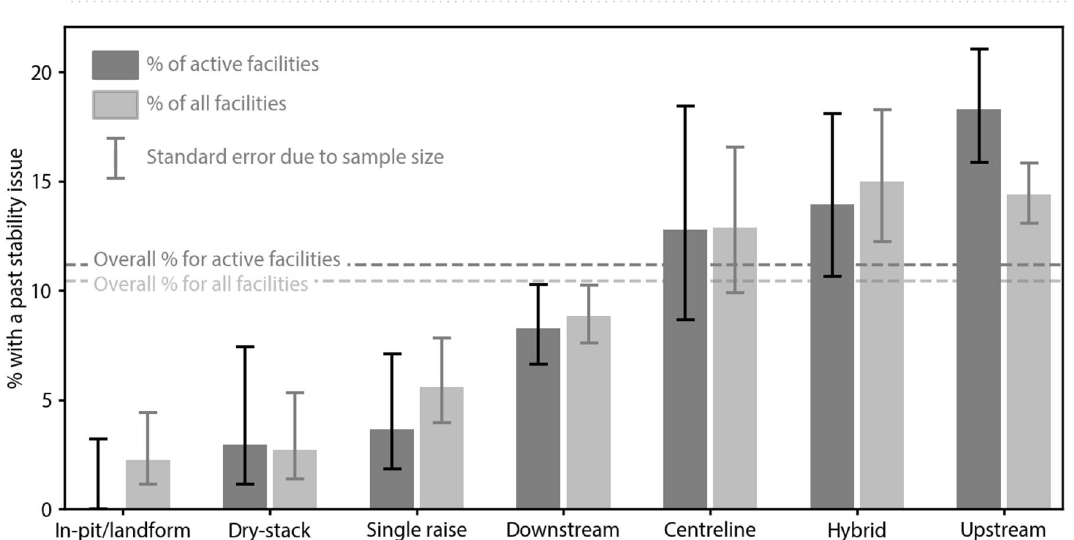
Figure 3. Stability of tailings facilities. Proportion of facilities with a stability issue by raise type. Error bar lengths are binomial confidence intervals for the subsample represented by each bar, showing ± 1 standard error (approximately